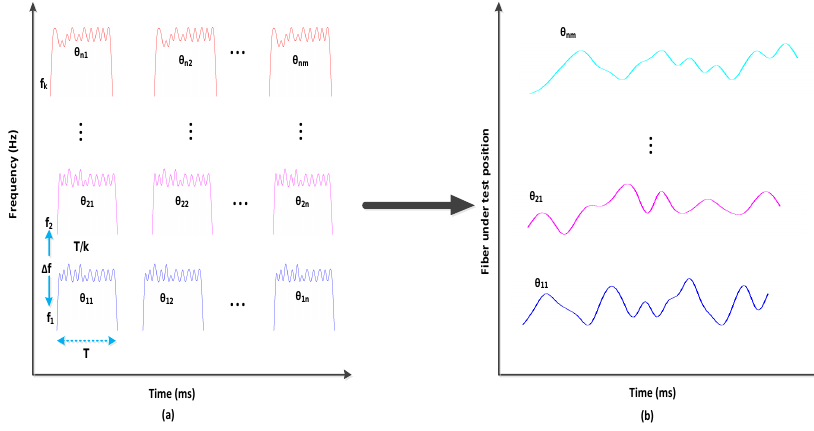
Figure 7. ( a ) Trace OTDR wave processing. ( b ) After